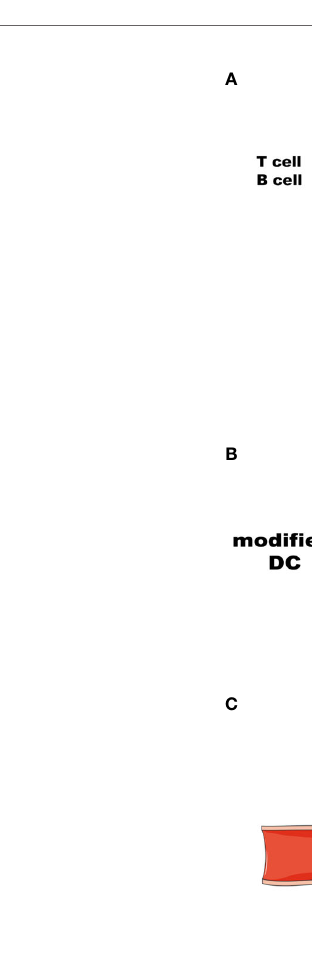
FIGURE 3 | Strategies for therapeutic induction of TLS formation. TLS inducers, such as chemokines, cytokines, DCs, and therapeutic approaches, can induce TLS formation in different ways. (A) Cytokines and chemokines involved in lymphogenesis, including LIGHT, CCL21, CXCL13, LT, and IFN- g , can lead to the formation of TLSs. LIGHT-VTP targeting tumor vessels can induce vessel normalization, and HEV and TLS formation may occur through a self-amplifying loop. The mechanism may be related to the LIGHT-triggered expression of the in fl ammatory cytokines IL-6, TNF, and CCL21 in macrophages. These chemokines can recruit T cells. Macrophages and T cells play an important role in the formation of HEVs and TLSs (83). HEV formation and vascular normalization can also recruit more immune cells. (B) Some immune cells, such as modi fi ed DCs and stromal cells, leading to the formation of TLSs. DCs engineered to secrete IL-36 g also initiate therapeutic TLS formation, which can upregulate the expression of T-bet. T-bet and IL-36 g cooperate to reinforce their expression and recruit immune cells, leading to TLS formation. DCs modi fi ed with the CCL21 gene can signi fi cantly increase T cell in fi ltration. Activated DCs can also upregulate many factors associated with TLS formation. (C) Biomaterials can provide 3D scaffolds in situ and deliver cells and chemokines. Collagen scaffolds containing LT, CCL21, CXCL13, and activated DCs were transplanted into mice. The recruited lymphocytes can form arti fi cial lymph node